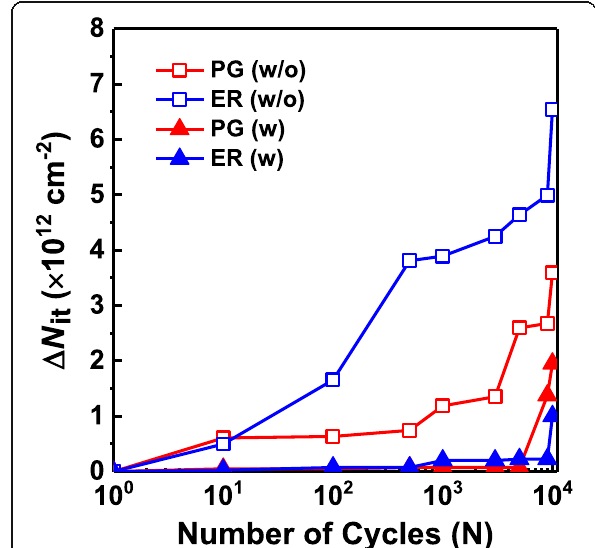
Fig. 5 Evolution of Δ N it with P/E